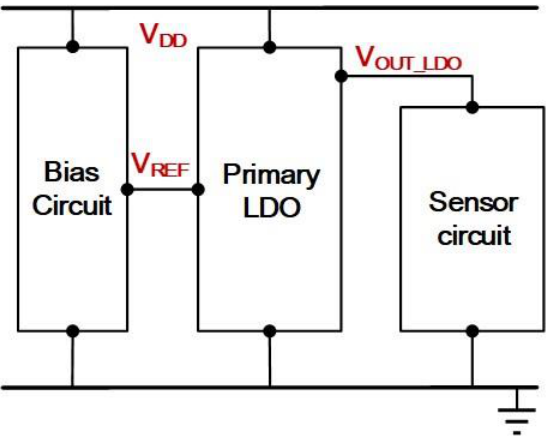
Figure 1. A Sensor Circuit Powered by a LDO Regulator.